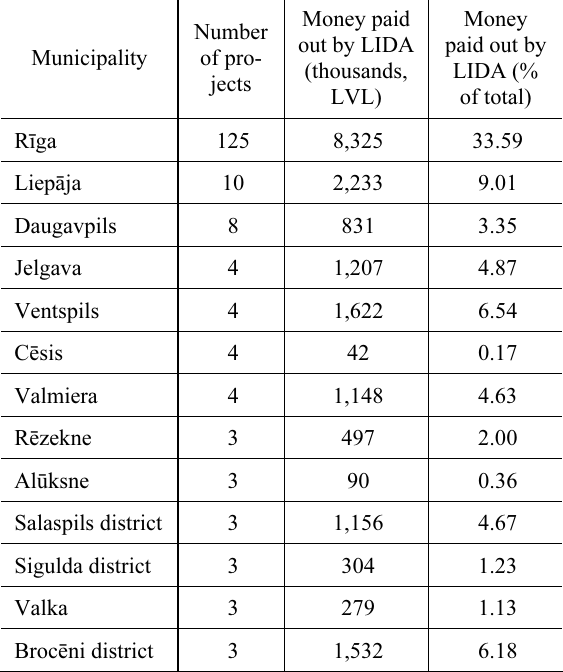
Table 9. Distribution of the money amount to structural fund recipients in the SRDA-administered program “Sup- port to investment in business development in